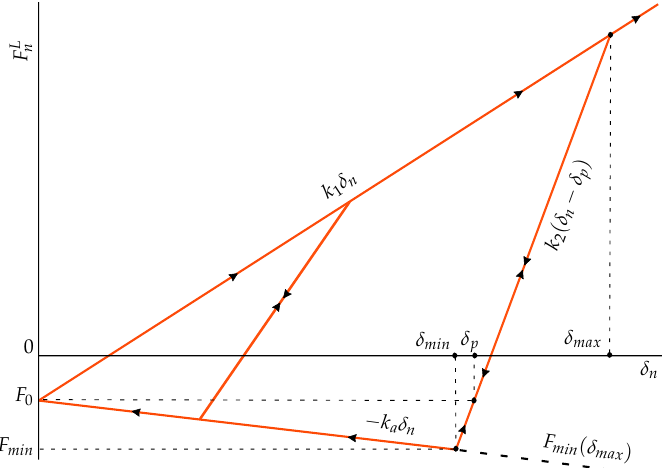
Figure 2. Luding’s model force-displacement relation in the normal